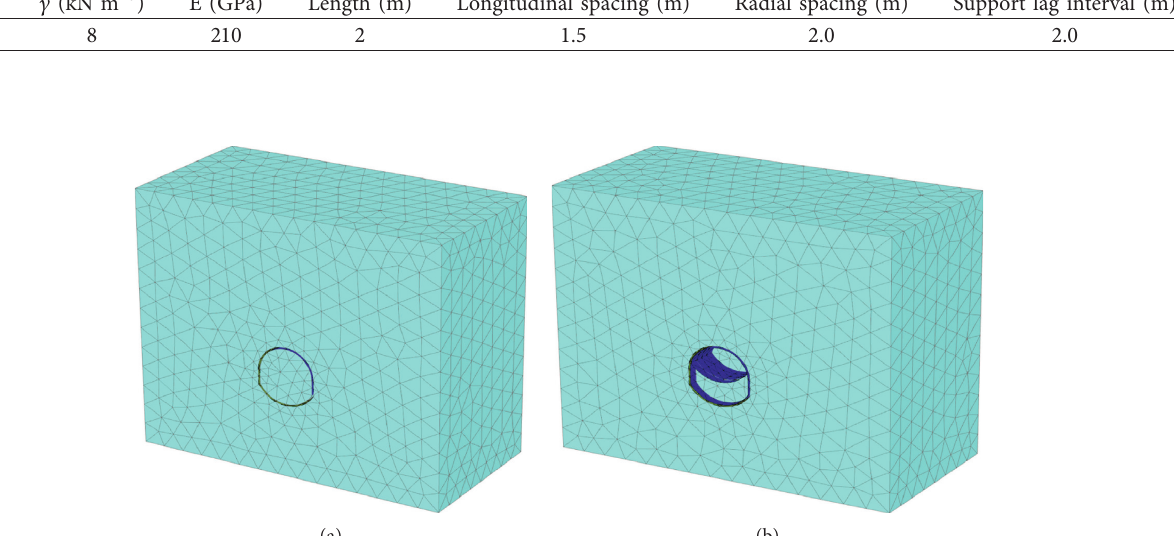
Figure 3: Excavation and dimensional boundary model: (a) full-face method; (b) two-step method.